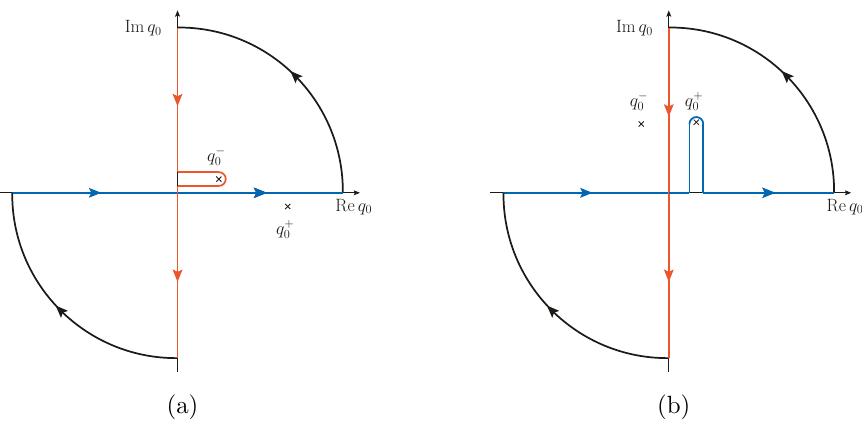
Figure 2. Integration contour in the complex plane q 0 before (2a) and after (2b) analytic continu- ation of the external momenta into the Euclidean region. The Feynman propagator poles q (cid:6) in the complex plane and the blue and red integration paths must be deformed